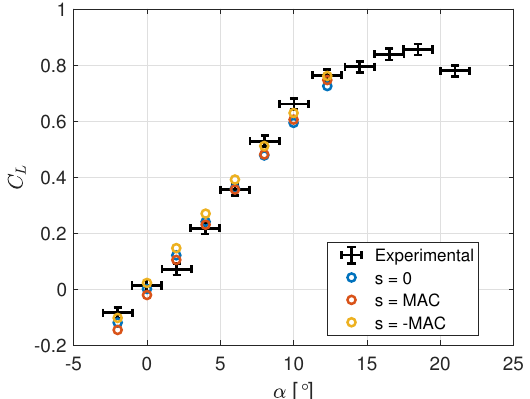
Figure 5. C L vs. α curve for different stagger values (APAME); kite geometry, other than stagger, can be found in Table 4